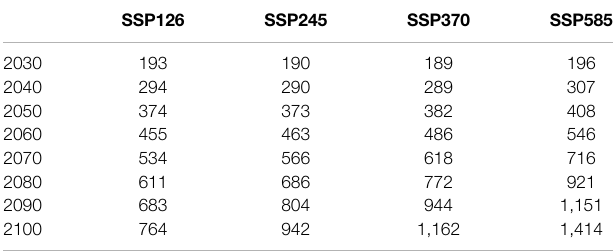
TABLE 1 | Increase in the number of glacial lakes ( > 0.1 km 2 ) in HMA under four SSP scenarios, represented by a 15-GCM ensemble